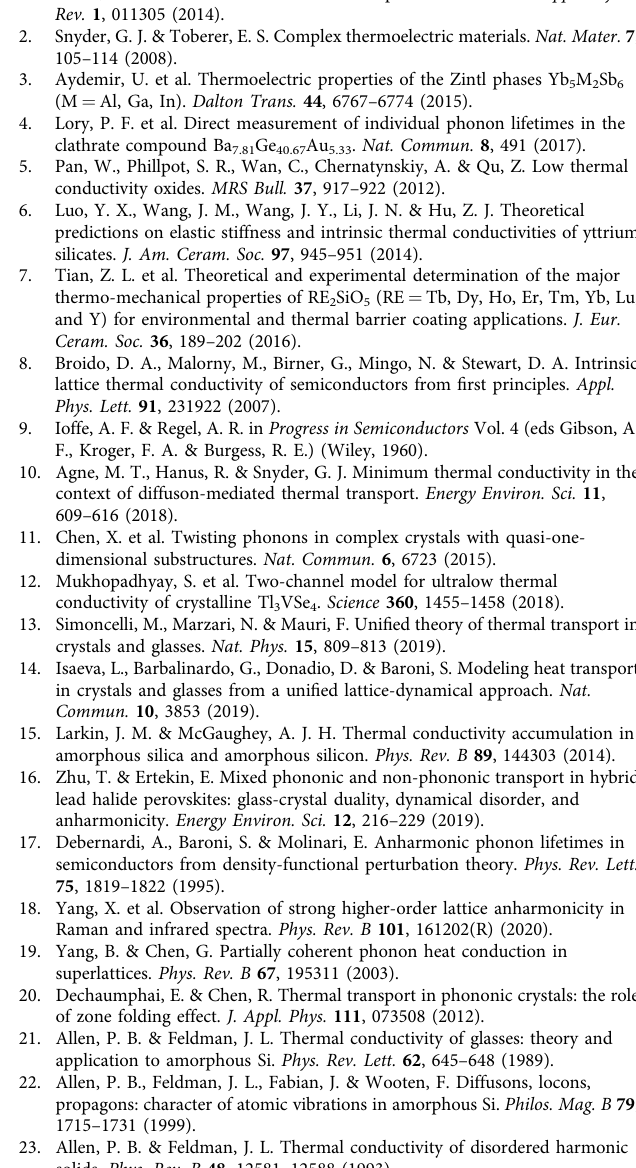
ffiffiffiffiffiffiffiffiffiffiffiffiffiffiffiffiffiffiffiffiffiffiffiffi ω ð Þ ω K j